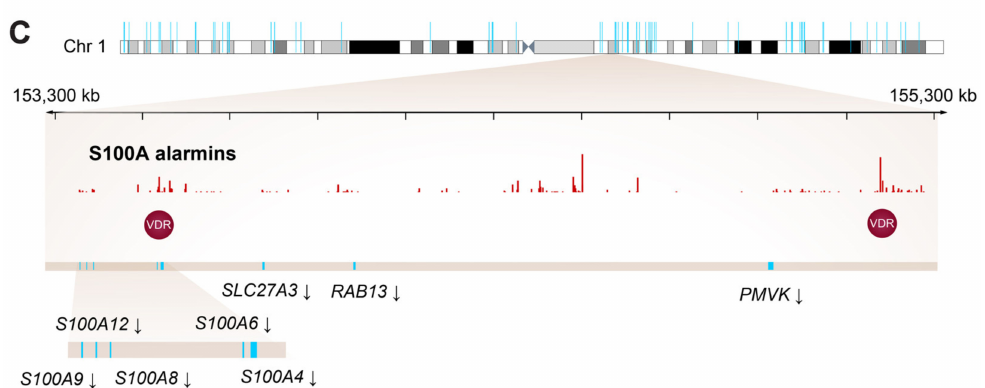
Figure 4. Hotspots of vitamin D signaling. Karyoplots showing the location of vitamin D target genes (blue) highlight regions encoding for HLA genes in chromosome 6 ( A ), CXCL genes in chro- mosome 4 ( B ) and S100A genes in chromosome 1 ( C ). VDR ChIP-seq data from THP-1 cells [25] monitor 1,25(OH) 2 D 3 -triggered VDR binding at indicated regions. Persistent binding sites of VDR are highlighted by red circles. Arrows indicate direction of regulation of target